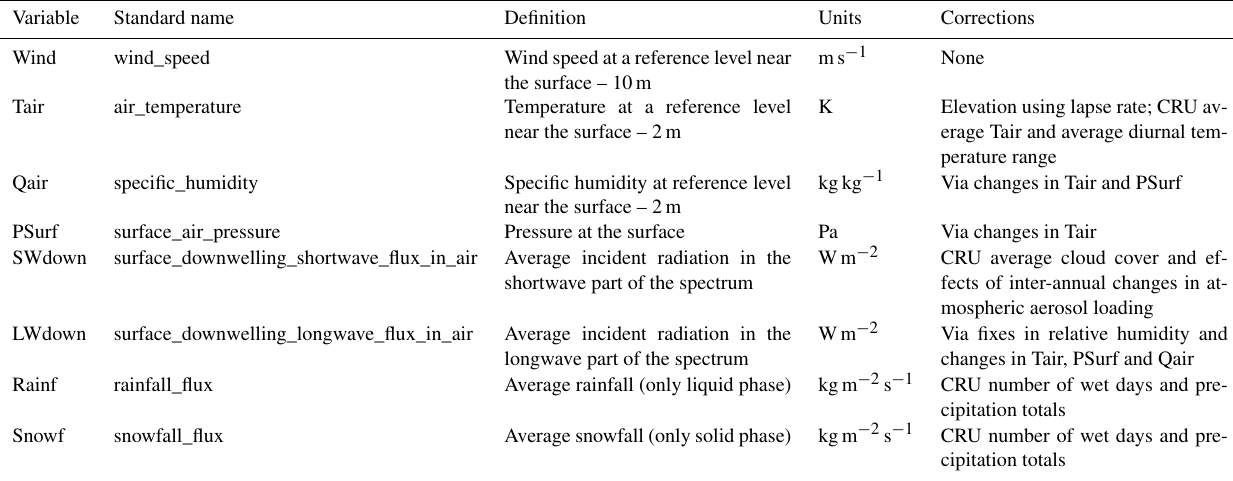
Table 2. Overview of the meteorological forcing used in the simulations, and the corrections applied to the original ERA-Interim during the WFDEI processing (Weedon et al., 2014).